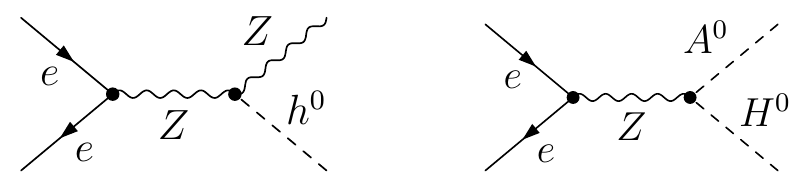
Figure 5 . Tree level Feynman diagrams for e + e − → Zh 0 and e + e − → H 0 A 0